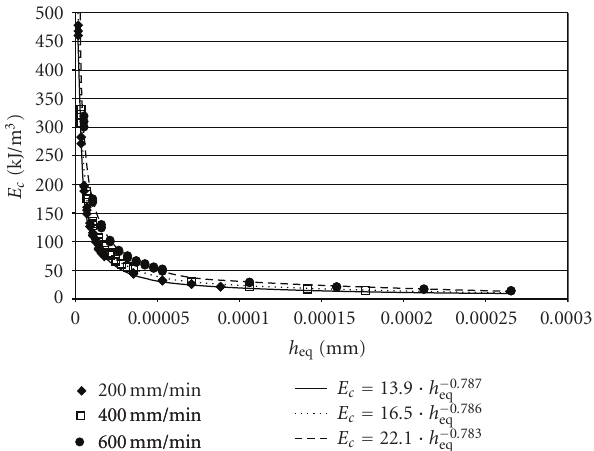
Figure 5: Comparison among model and experimental data of E c versus h eq and v a .